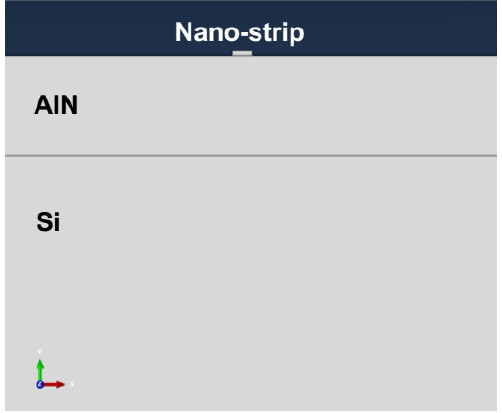
Figure 3. Finite element model of the Au nano-strip, AlN thin film and Si substrate. Table 1. Material properties of Au, Si and AlN [20 – 22] .